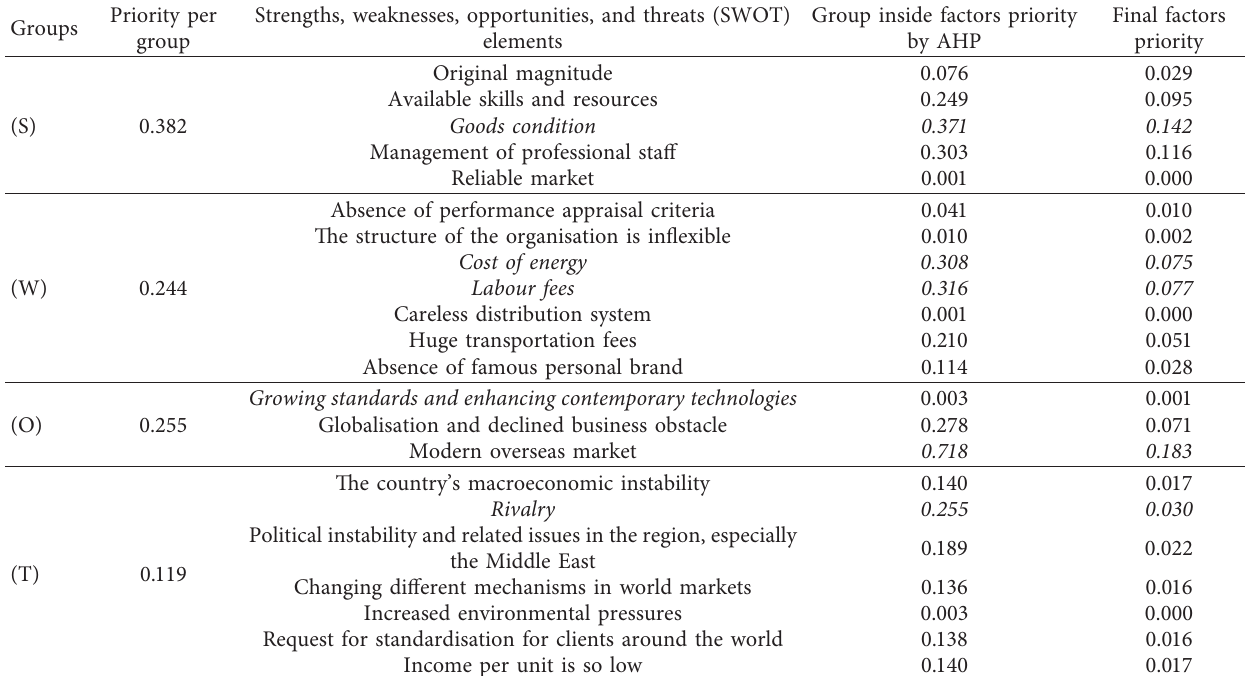
Table 12: Final priority scores of SWOT elements via